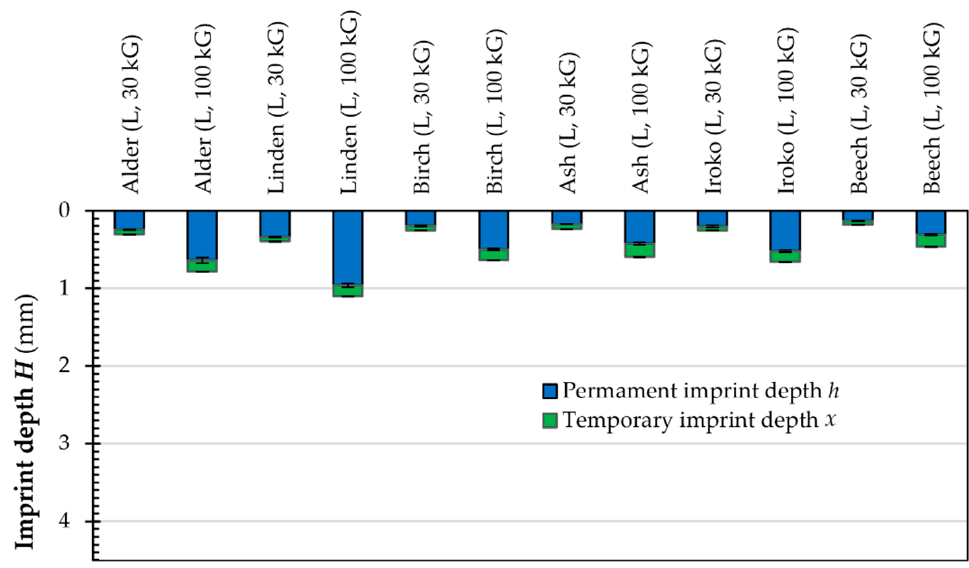
Figure 9. Imprint depth under measuring load (longitudinal direction).